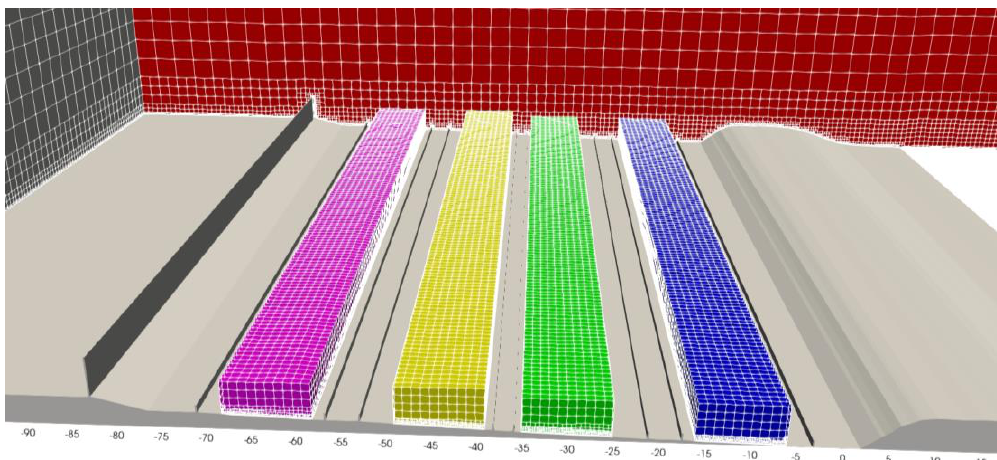
Figure A2. Four rectangular cuboids representing the traffic lanes and used as volumetric sources for the traffic momentum and turbulence in the modeling of the stationary wind velocity field and in the passive scalar equation as volumetric sources for PM emission.